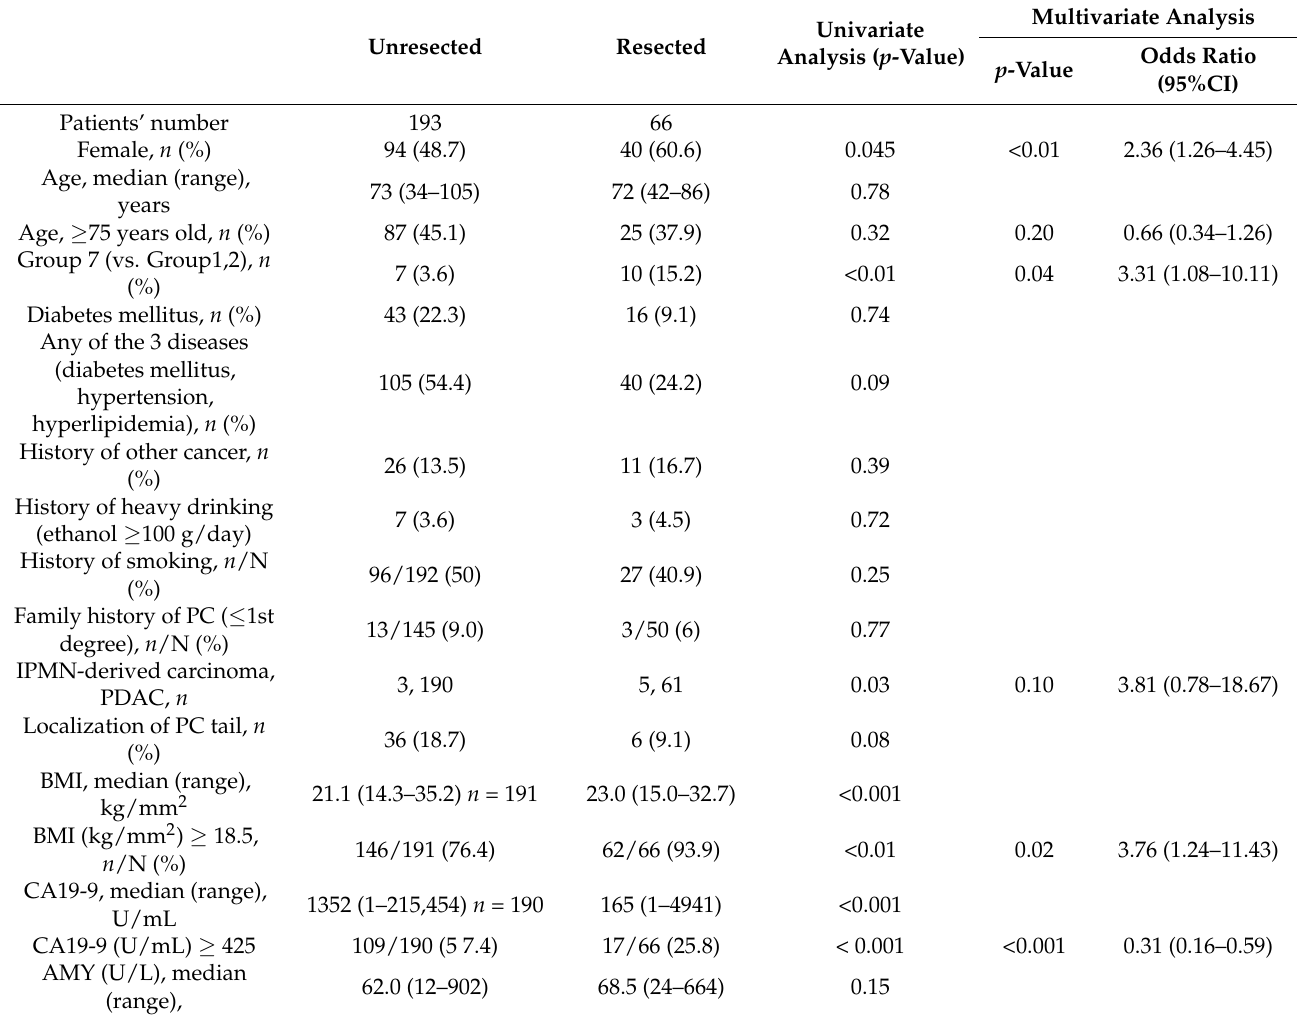
Table 3. Comparison of characteristics between resected and unresected patients in Groups 1, 2, and